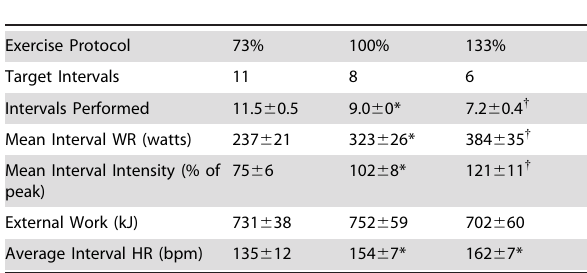
Table 2. Descriptive statistics for individual interval